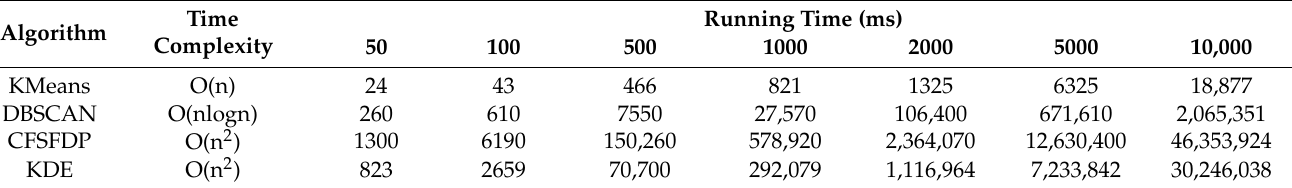
Table 9. Running time of four algorithms.